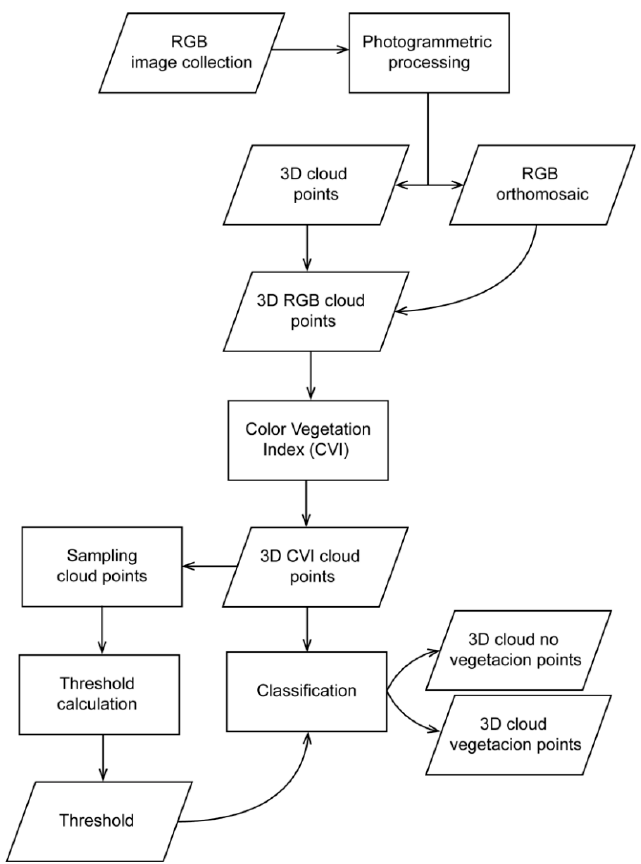
Figure 2. Flowchart used for the classification of